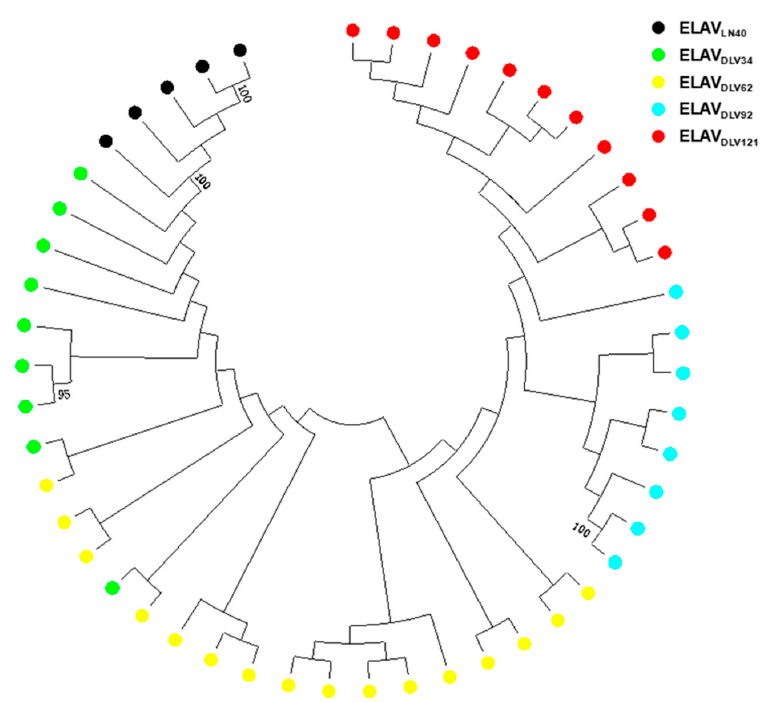
Figure 1. The evolutionary history was inferred by applying MEGA 7.0 program based on the general time reversible model. Whole genome sequences were obtained by bulk PCR. Bootstrap values above 80% are indicated. EIAV LN40 , EIAV DLV34 , EIAV DLV62 , EIAV DLV92 , and EIAV DLV121 are presented with black circles, black triangles, gray circles, blue circles and red circles, respectively.